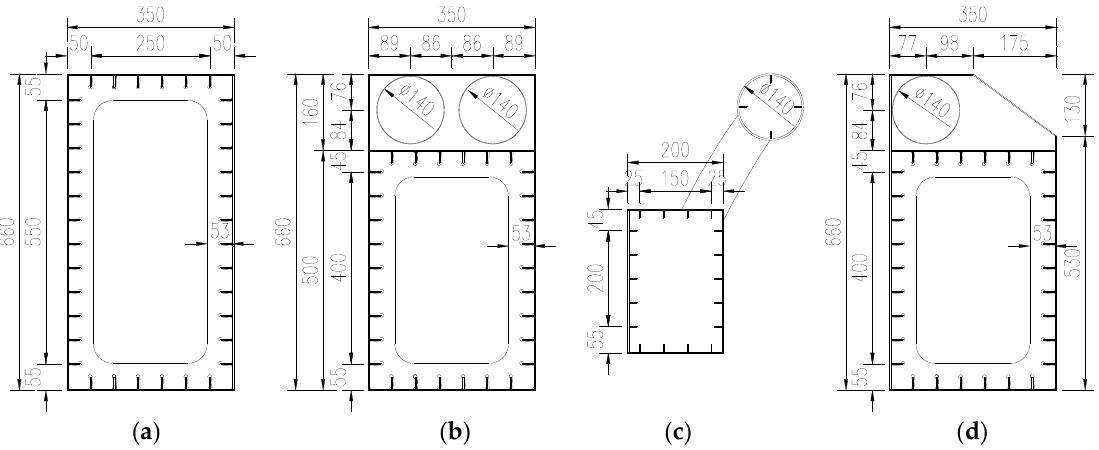
Figure 4. Characteristic sections of arch ribs (unit: cm): ( a ) Section A-A; ( b ) Section B-B; ( c ) Section C-C; ( d ) Section D-D.